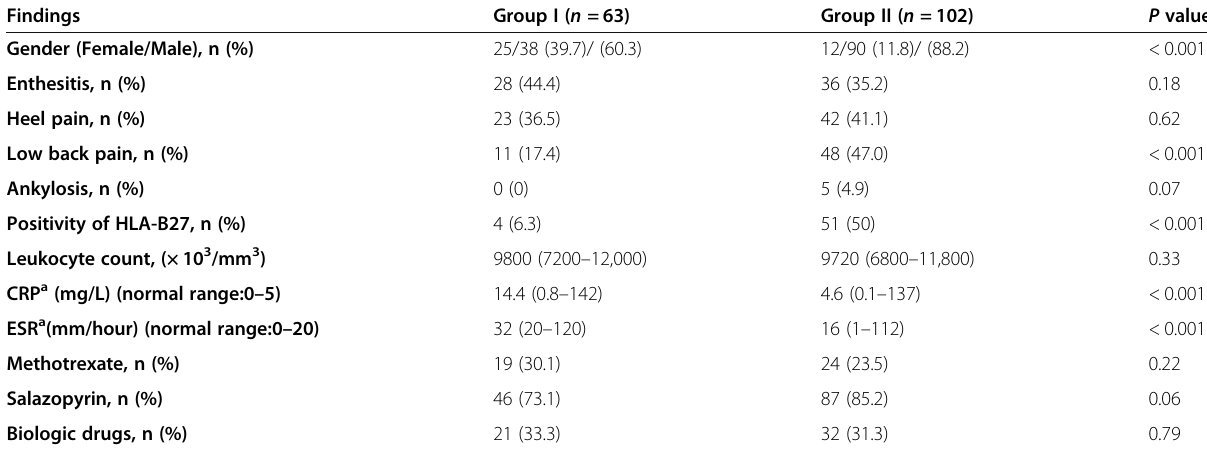
Table 2 Comparison of Group 1 and Group II patients